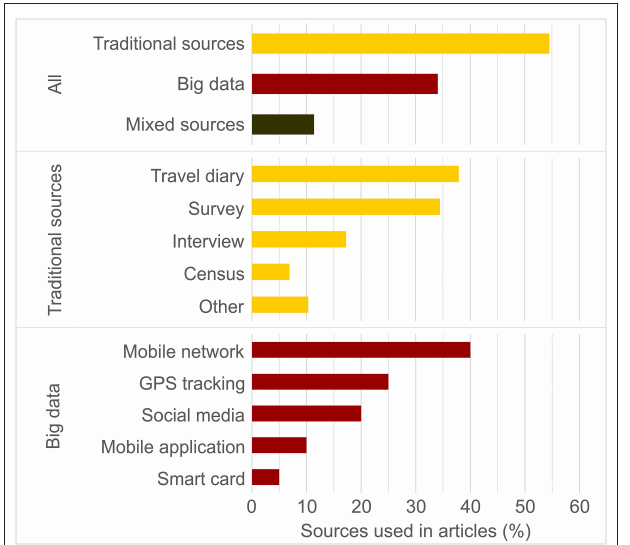
FIGURE 3 | Distribution of articles by data source type used for analyzing activity spaces quantitatively ( n = 44, top section). Distribution of traditional sources ( n = 29, middle) and big data sources ( n = 20, bottom) used in articles ( n = 44).